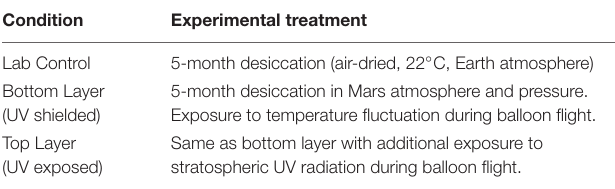
TABLE 2 | Overview of experimental design. Condition Experimental treatment Lab